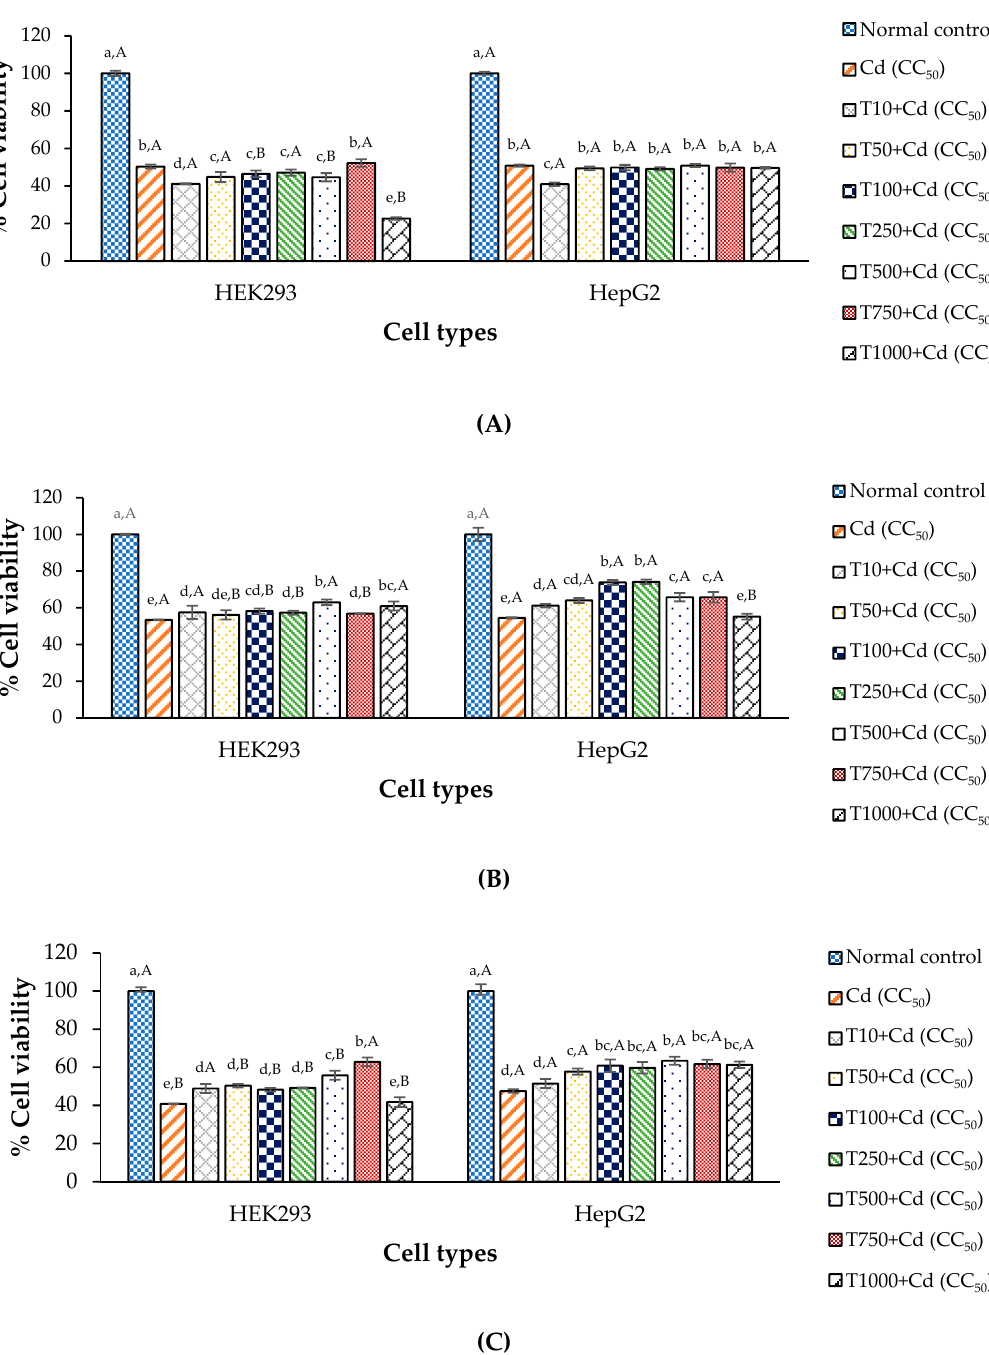
Figure 3. Anti-Cd toxicity of the CDE of T. laurifolia leaves in HEK293 and HepG2 cells determined by MTT assay; ( A ) combined-treatment; ( B ) pre-treatment and ( C ) post-treatment with CDE; a–e means with different letters are significantly different within a cell type ( p < 0.05); A,B means within an extract concentration with different letters are significantly different ( p < 0.05). T means the CDE of T. laurifolia leaves (µg/mL); Values are mean ± standard deviation.